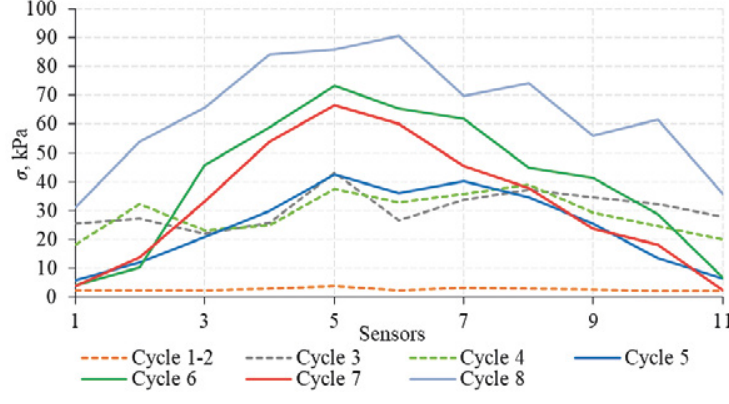
Figure 6. Distribution of maximum stresses under the ballast depending on the program of experimental